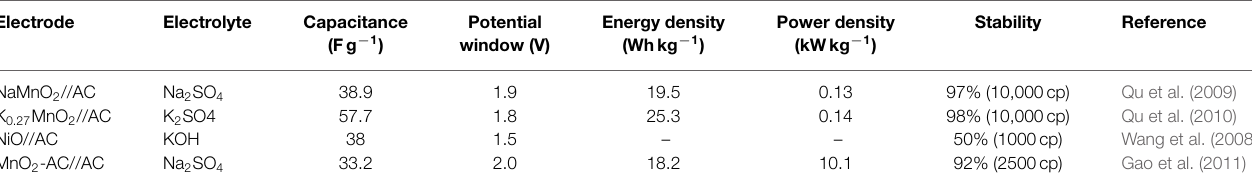
TABLE 2 | Electrochemical performance of the asymmetric supercapacitors based on conventional electrode materials .